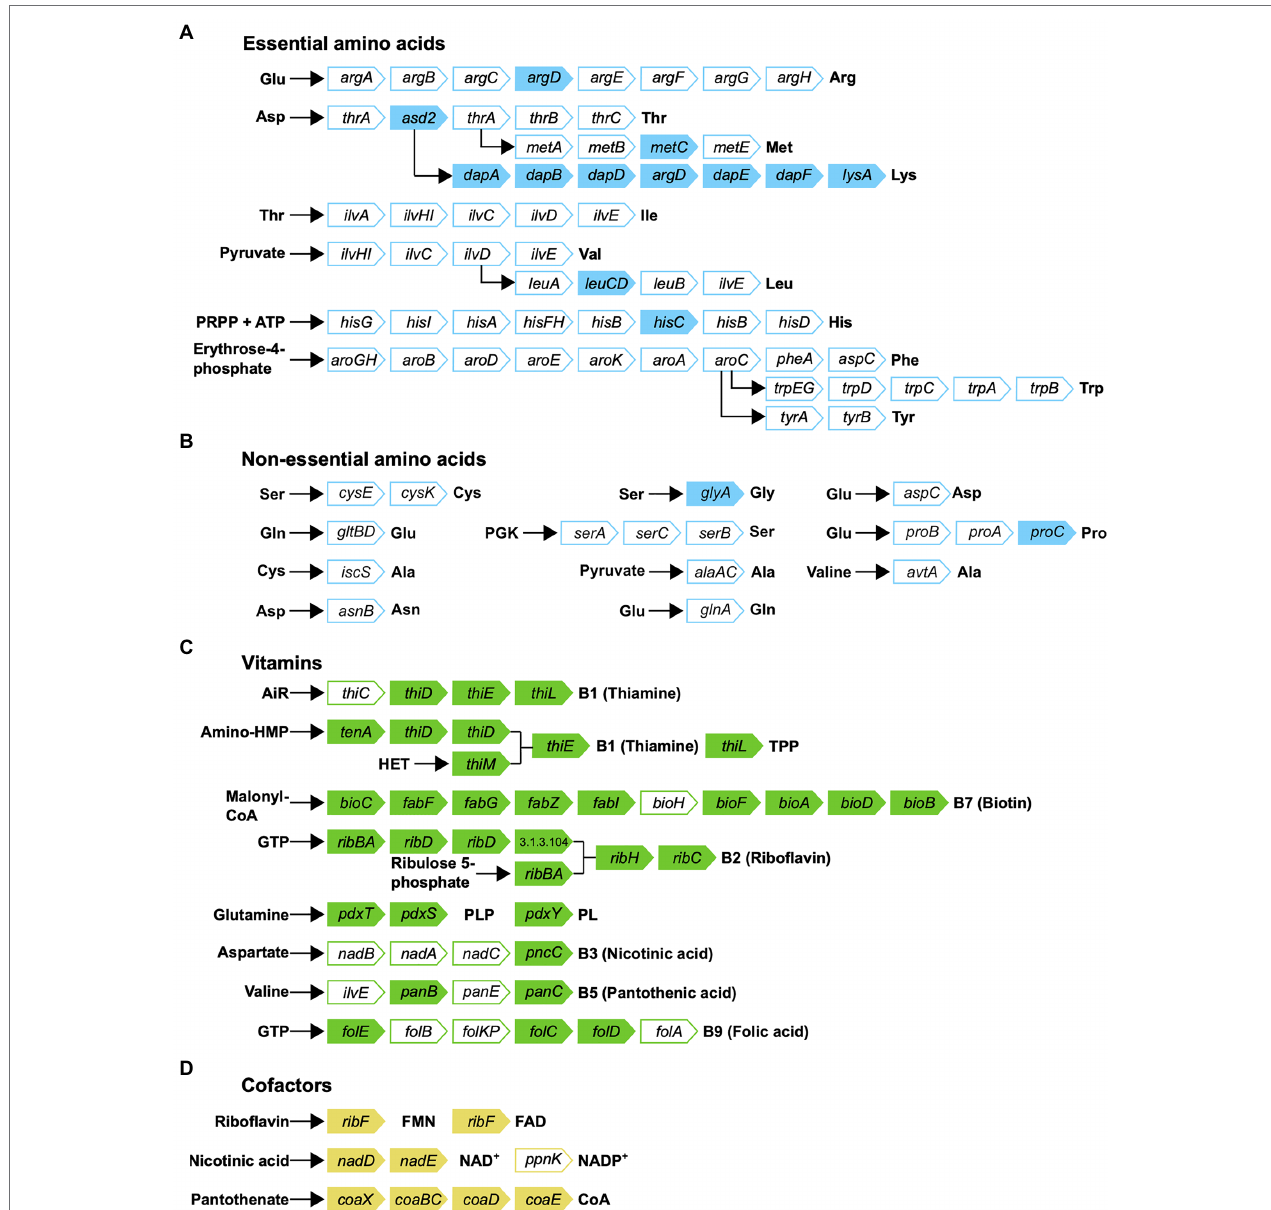
FIGURE 7 | Biosynthetic pathways for synthesis of (A) essential amino acids; (B) non-essential amino acids; (C) vitamins; and (D) cofactors in Rickettsiella DGE. Gene names are indicated in arrowed rectangles; colored arrows show genes present in Rickettsiella DGE; missing genes are shown in white